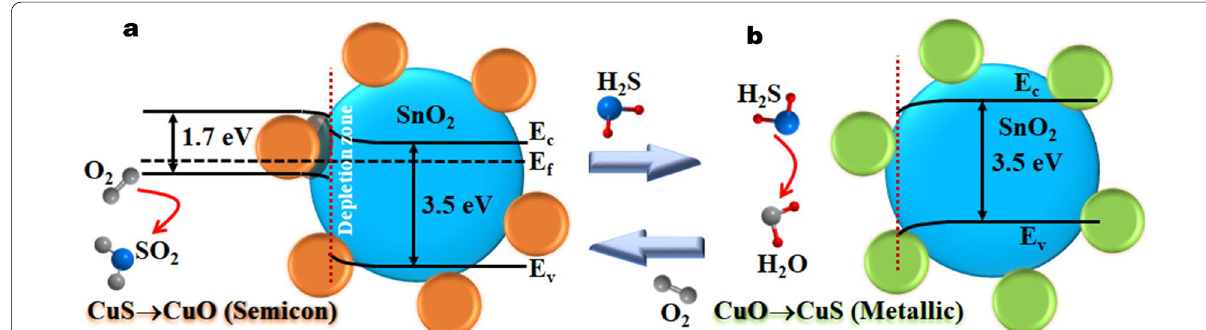
Fig. 11 Energy band diagrams of CuO/SnO 2 heterojunctions a before and b after exposure to H 2 S ( E f and E V valence =